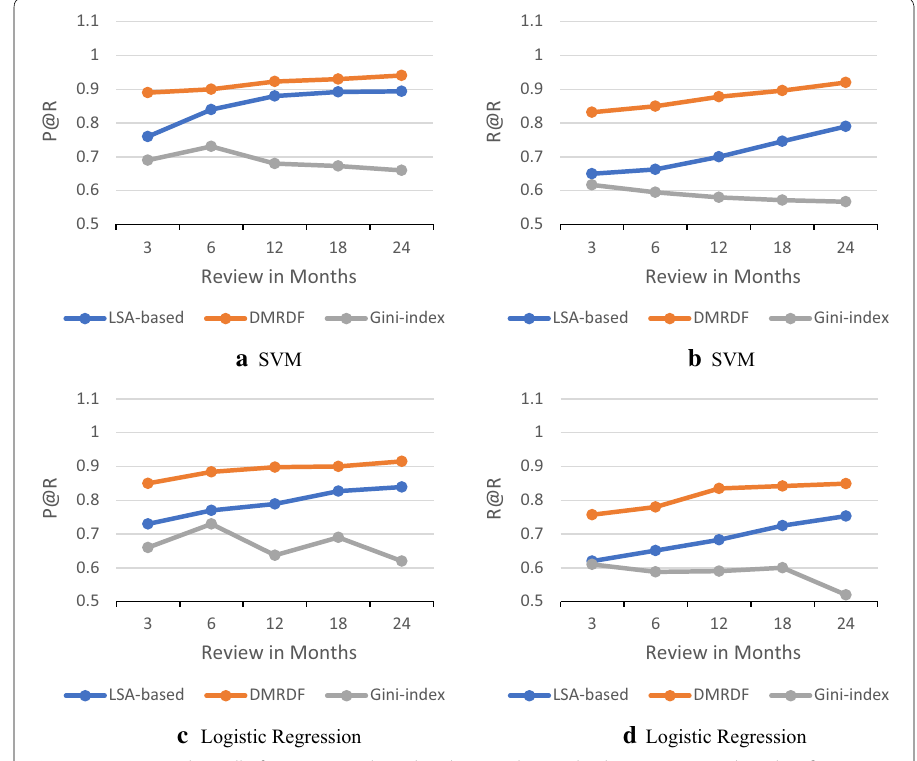
Fig. 4 Precision and Recall of DMRDF, LSA-based and Gini-index methods using SVM and LR